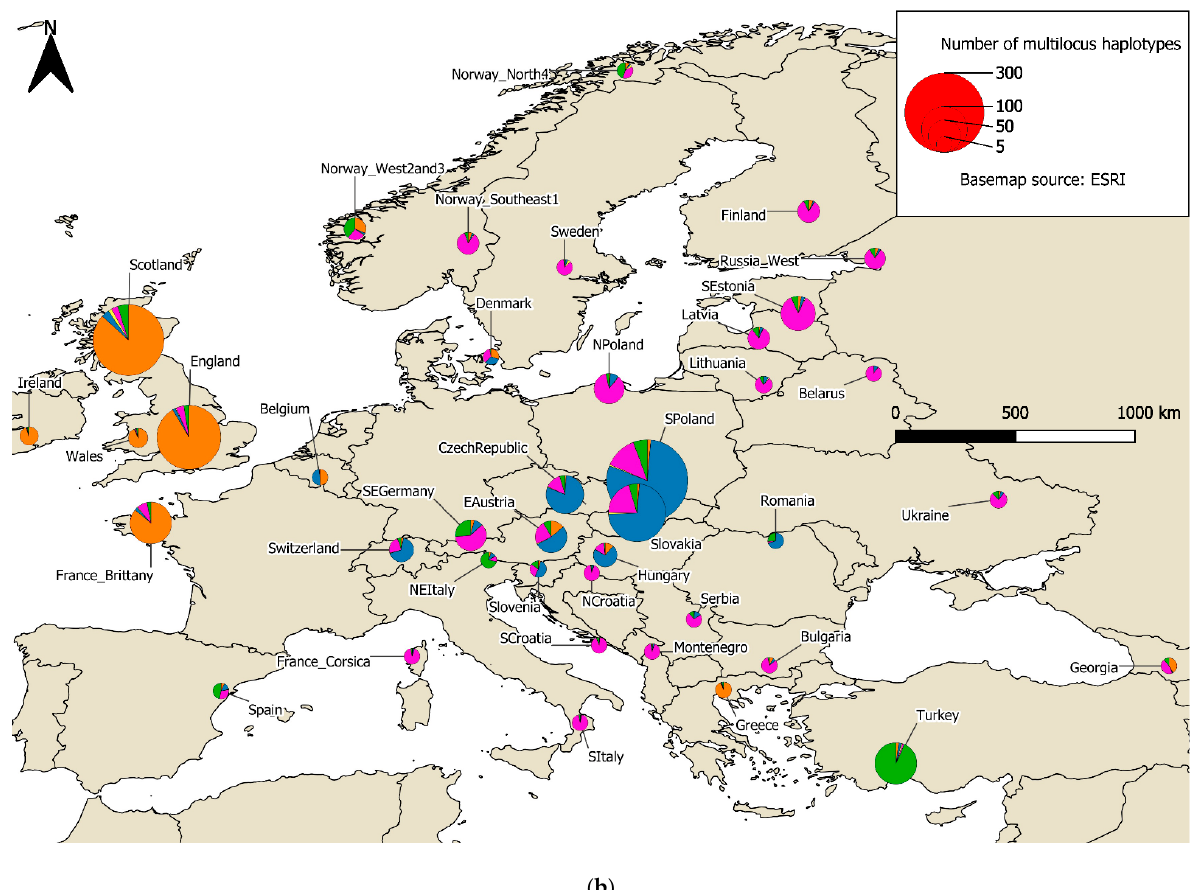
Figure 1. ( a ) World map of D. septosporum population groups and their STRUCTURE membership at K = 3; ( b ) European map of D. septosporum population groups and their STRUCTURE membership at K = 5.